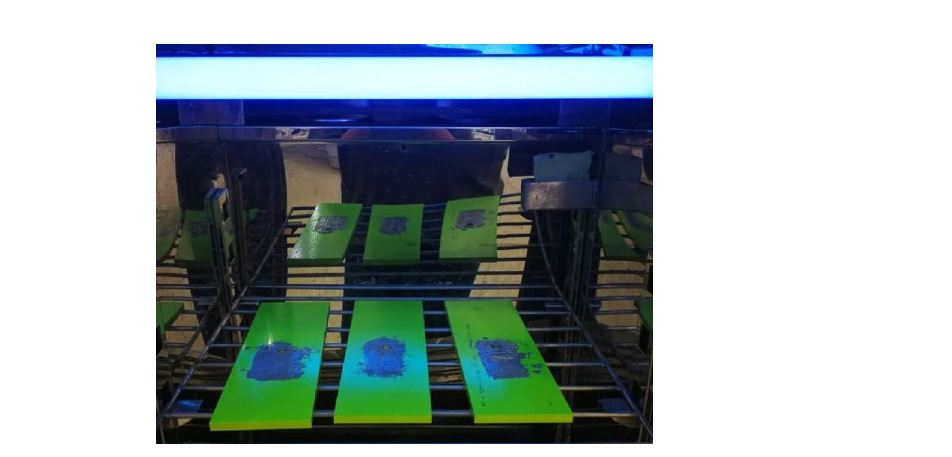
Table 6. Monitoring results in fluid immersion environmental experiment.